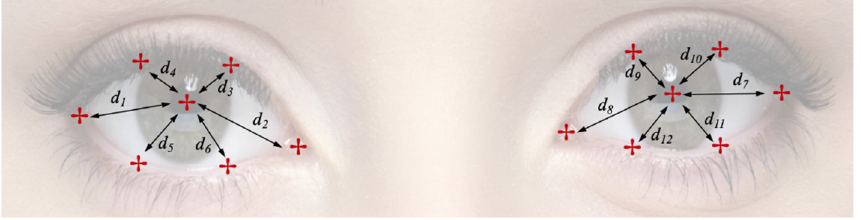
Figure 3. Detected Landmarks and corresponding distances from the pupil centres used for feature extraction. Features from the two eyes were treated independently for attack detection in this implementation.